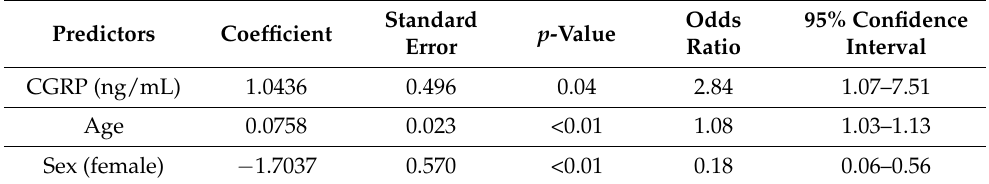
Table 6. Multivariate stepwise logistic regression of plasma CGRP levels at baseline (t0), predicting a negative disease evolution (in-hospital death or ICU admission) including demographic and clinical severity variables. The variables entered in the model are reported in the table. NEWS2 score and PiO 2 /FiO 2 did not enter the model.